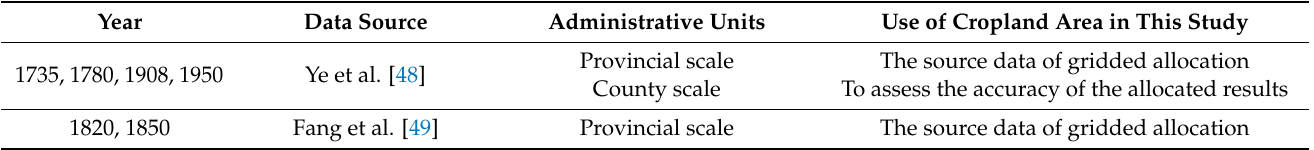
Table 2. The data sources, scales, and uses of cropland area in Jilin Province from 1735 to 1950. Year Data Source Administrative